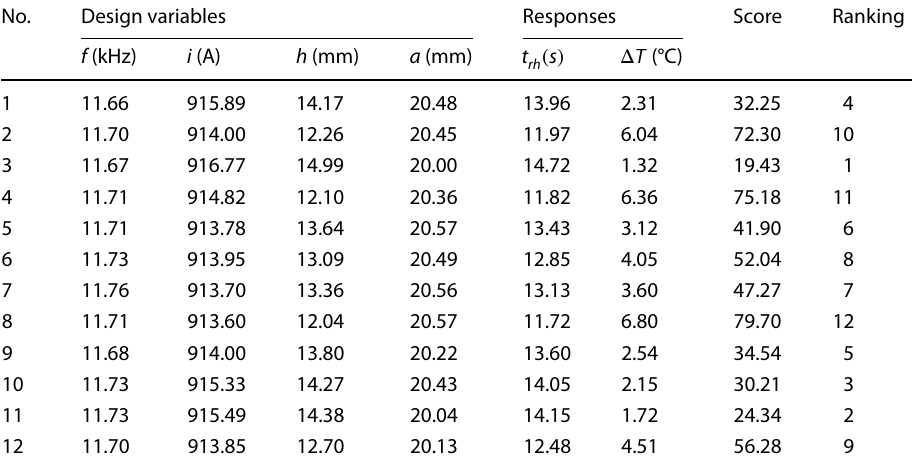
Table 5 Listing of some Pareto solutions (only top 12 candidates) and corresponding ranking based on score